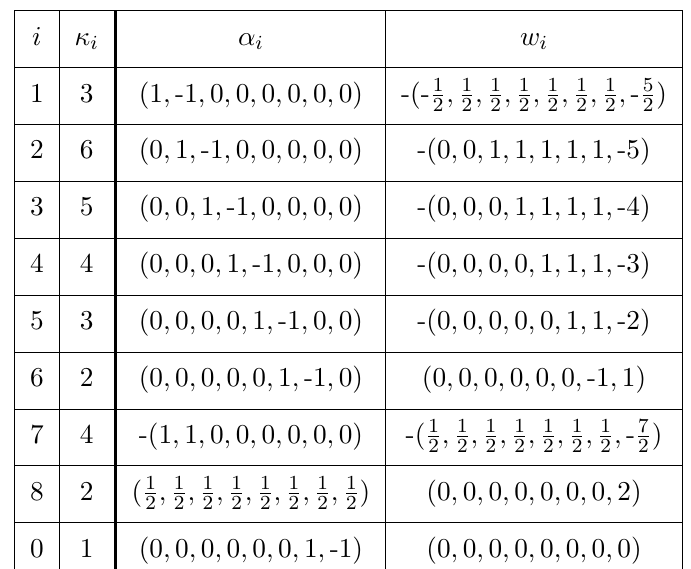
Figure 1 . Generalized Dynkin Diagram for the lattice II 1 , 9 . The coloring of the nodes 0 and C reflects the fact that the associated states have nonzero momentum and/or winding, as opposed to the white nodes.